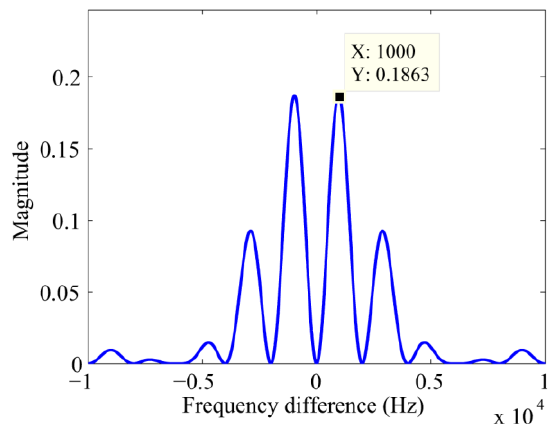
Figure 2. The curve of sinc 2 ( ∆ FN /2 )[ 1 − cos ( π ∆ FN )] .